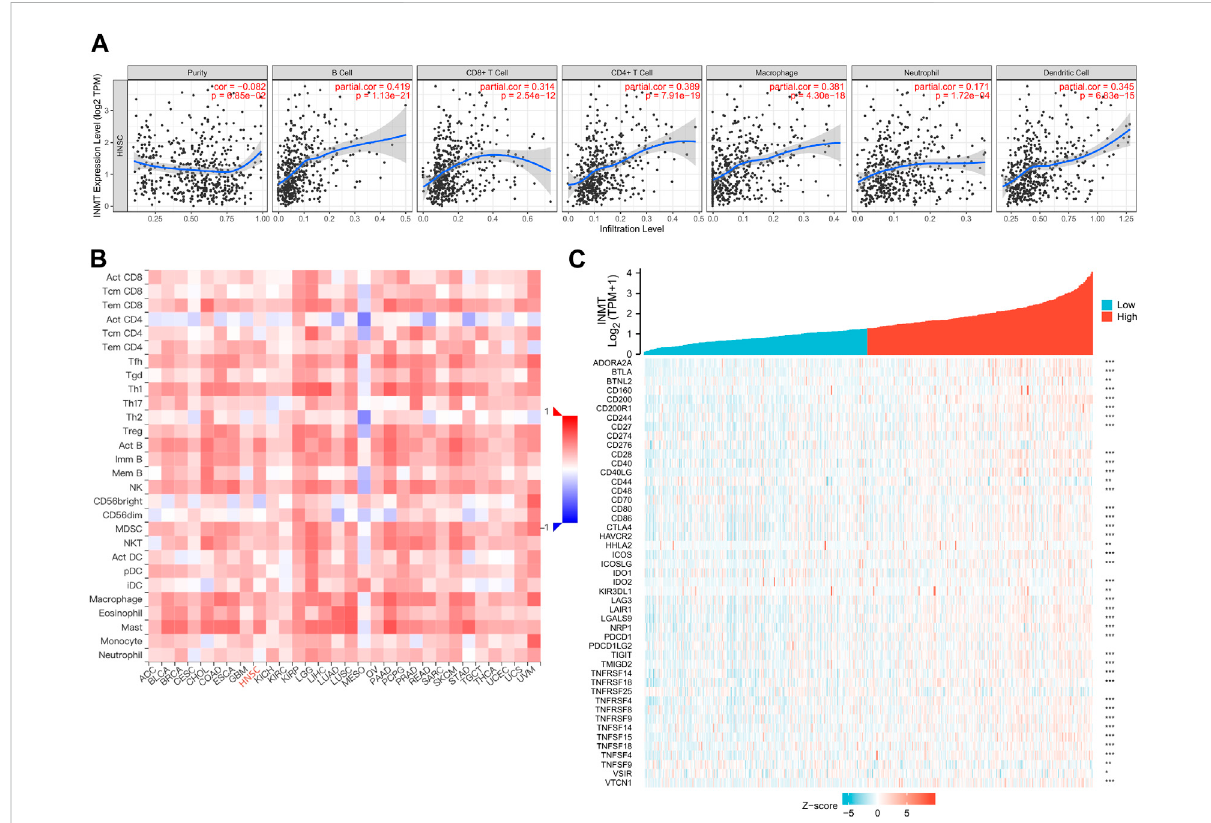
FIGURE 7 TherelationshipbetweentheINMTlevelandimmunein fi ltrationlevelinHNSC. (A) AnalysisofthecorrelationbetweenINMTexpressionandthe levels of immune cell in fi ltration inHNSCtissues usingtheTIMERdatabase. (B) RelationshipbetweenexpressionofINMT and 28typesofTILs across human heterogeneous cancers. (C) Relationship between INMT expression and the gene levels of more than 40 common immune checkpoints in